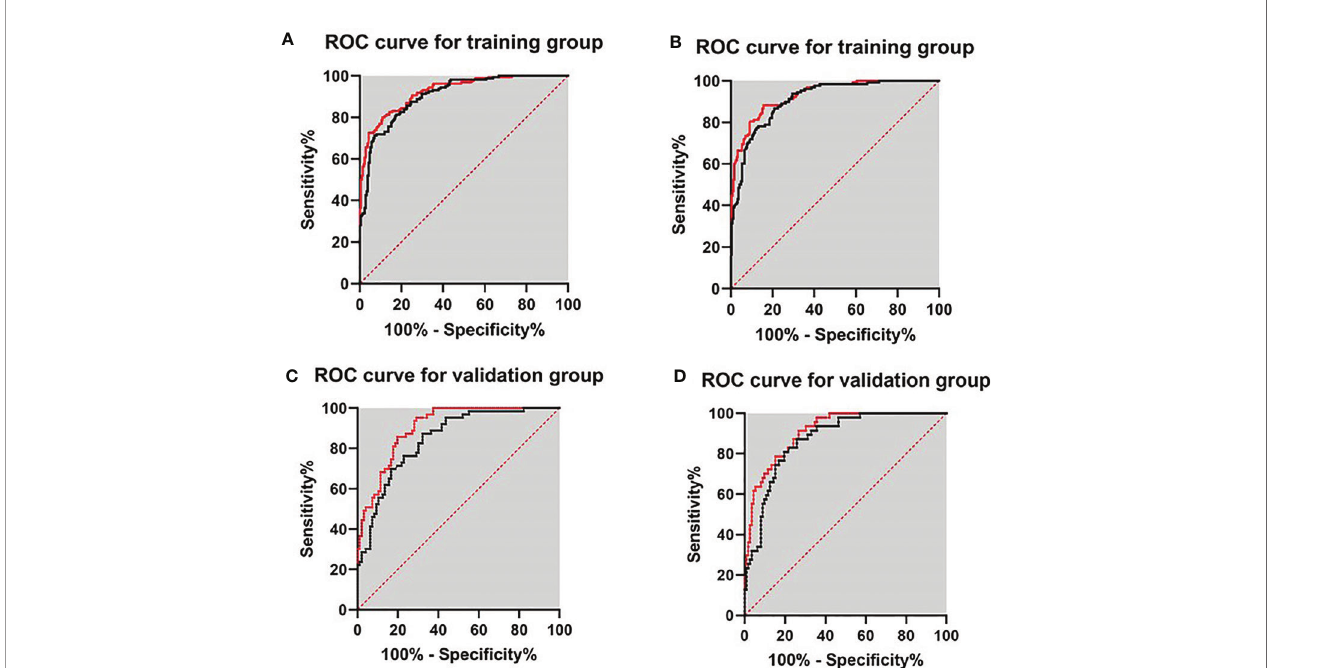
FIGURE 2 | ROC curves for validating the discrimination of two prediction models in the training group and validation group. (A) Diagnosis of PCa in the training group. (B) Diagnosis of csPCa in the training group. (C) Diagnosis of PCa in the validation group. (D) Diagnosis of csPCa in the validation group.